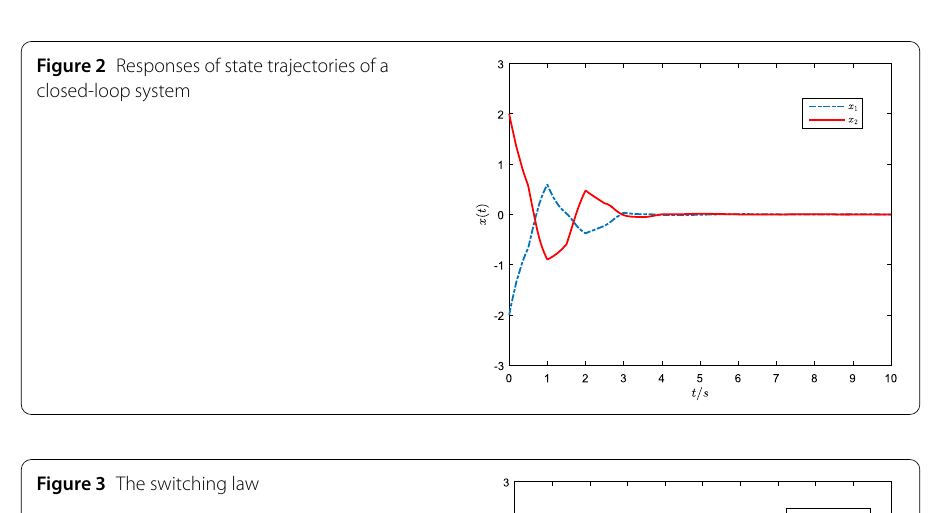
Figure 2 Responses of state trajectories of a closed-loop